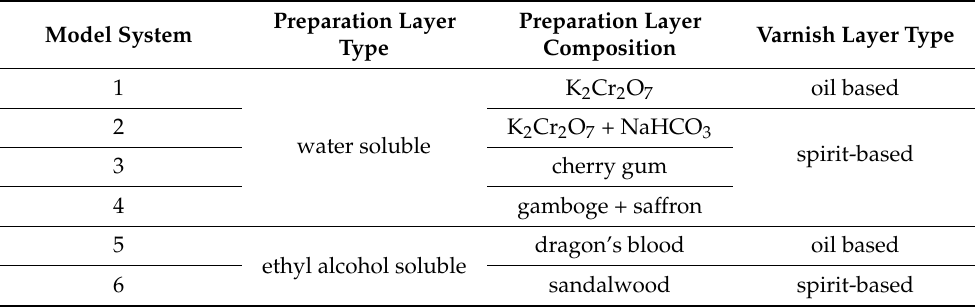
Table 1. Preparation layer composition of a set of varnished wood samples (1 to 6) prepared by Gabriele Carletti which, at the time of analysis, had been naturally aged for a period of four